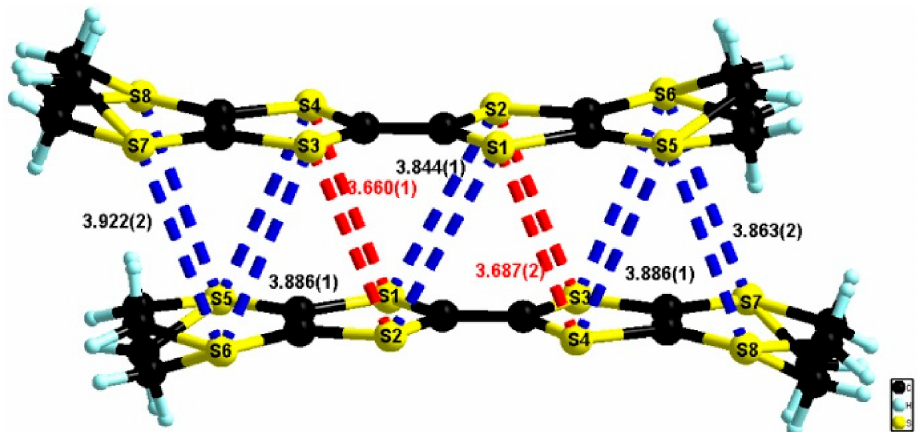
Figure 9. Dimers of donors in the structure of (BEDT-TTF) 2 (TaF 6 ) 2 · CH 2 Cl 2 with an emphasis on the short intermolecular S ··· S contacts.